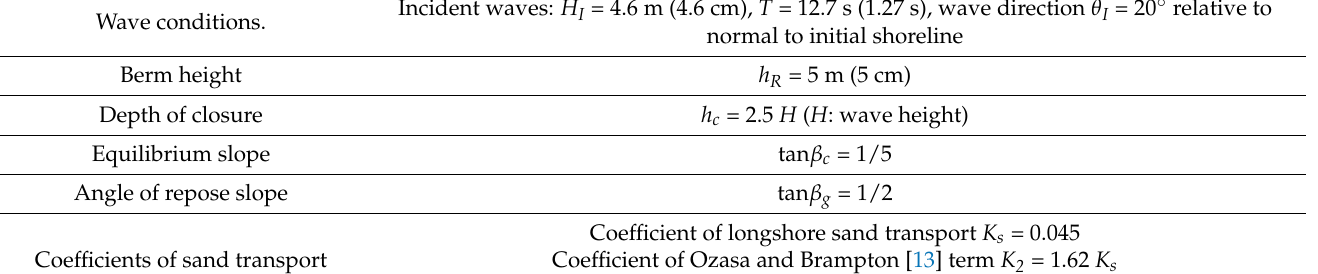
Table 2. Calculation conditions (numbers in parentheses: experimental conditions). Wave